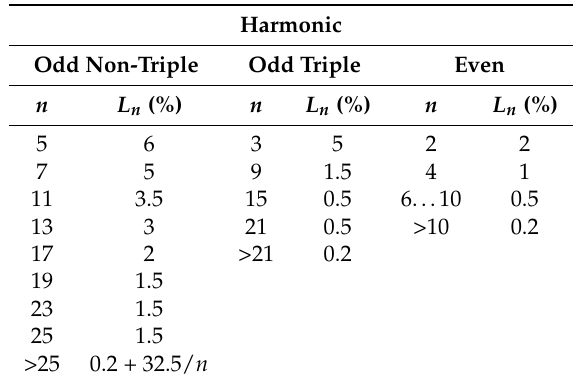
Table 1. Grid code EN 50160 + quality CIGRE WG36-05